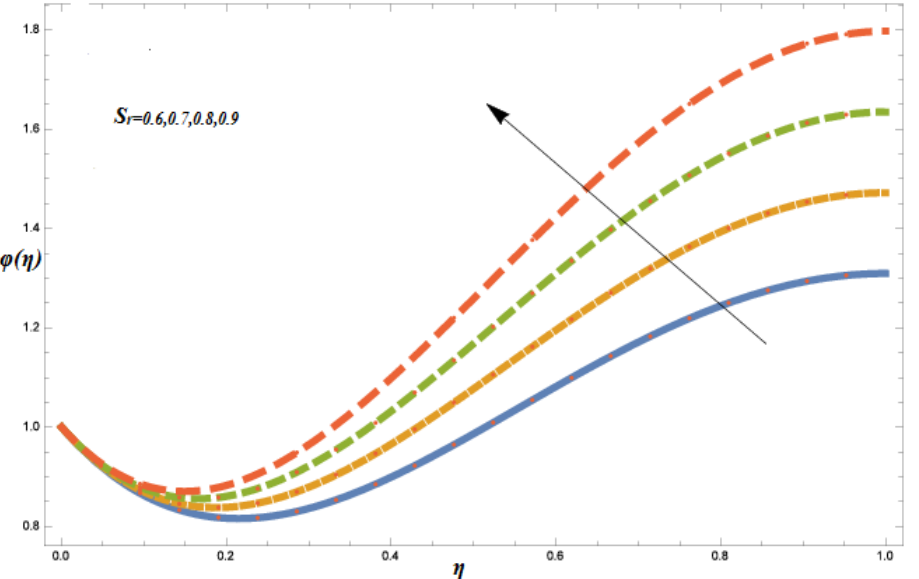
Figure 15. Variations in concentration field ϕ ( η ) occur for different values of D u , when (cid:125) = − 0.25, S = 0.7, B r = 0.7, N r = 0.7, P r = 10, S c = 0.7, ε = 0.7, S r = 0.7, λ = 0.7, Λ = 0.7, β = 1.